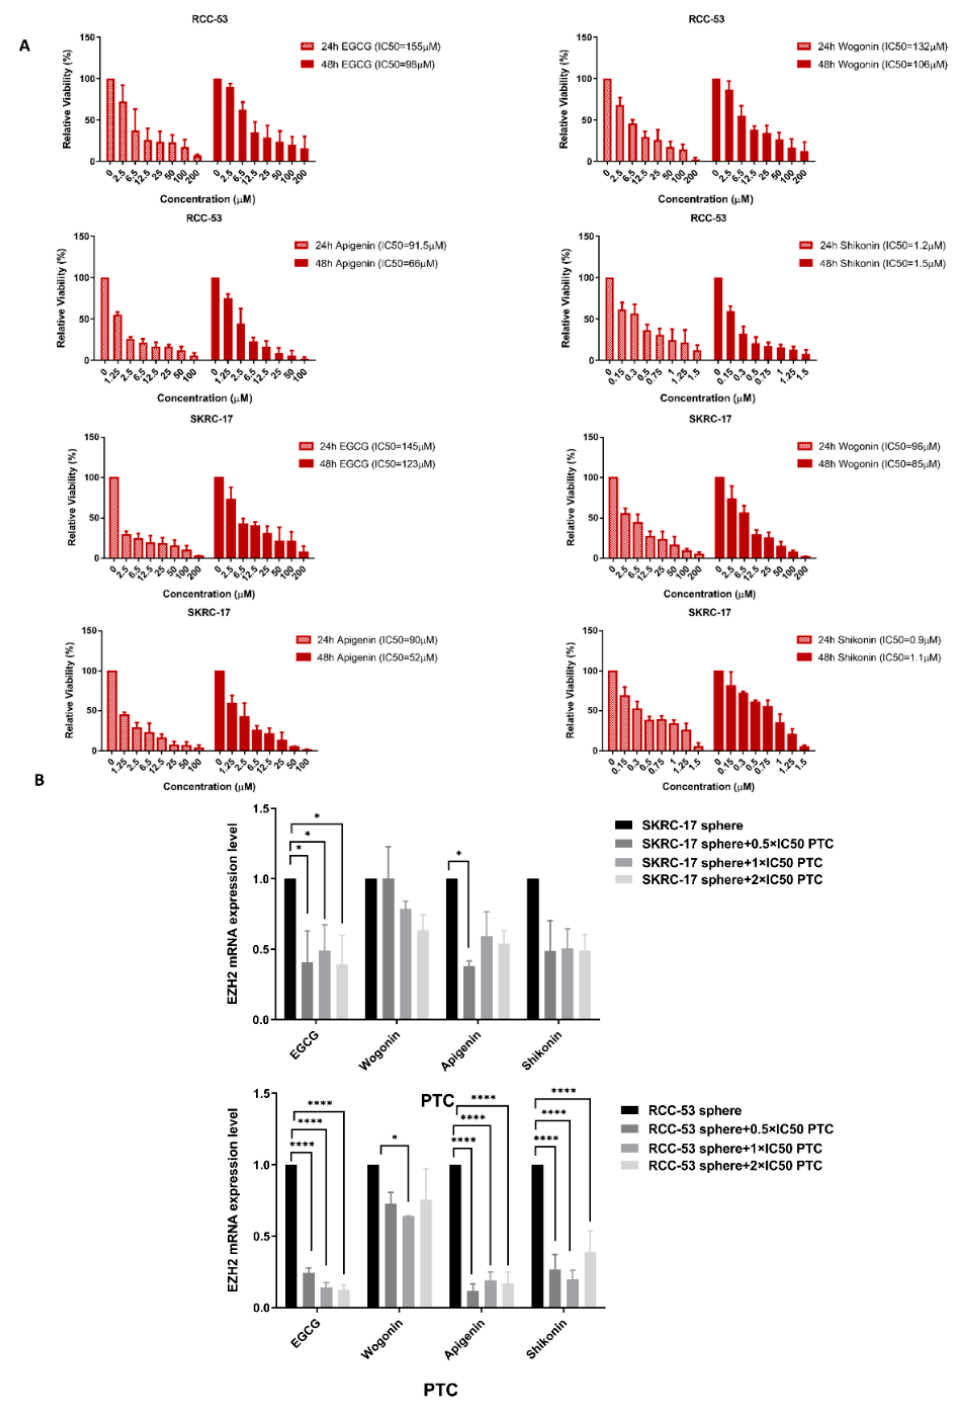
Figure 7. EGCG inhibited the expression of EZH2 in ccRCC CSCs. ( A ) CellTiter-Blue Cell Viability Assay: EGCG, wogonin, apigenin, and shikonin inhibited the viability of SKRC-17, RCC-53 in a dose-dependent manner, shown after 24 and 48 h. The half-maximal inhibitory concentration (IC50) was calculated by the logit regression model. ( B ) RT-qPCR analysis: EGCG, wogonin, apigenin, and shikonin reduced the expression of EZH2 in the sphere cells, normalized expression levels are displayed ( n = 3, * p < 0.05, **** p <